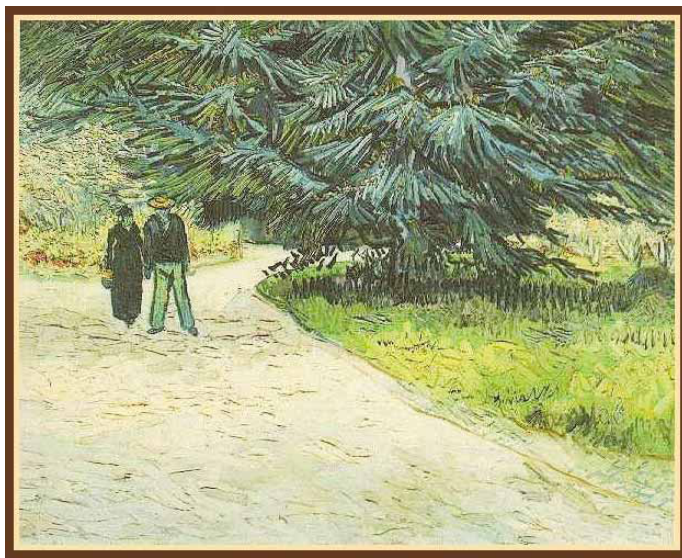
Fig. 2. Vincent van Gogh. Lovers: Poet’s Garden IV . October